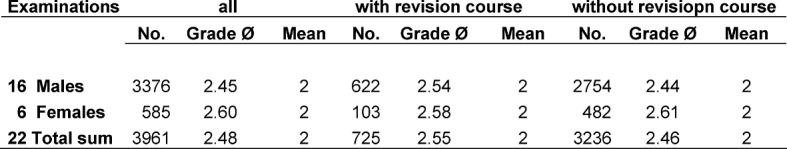
Arithmetic mean and median value of all examination results, from the experimental group with revision course and the comparison group without revision course, separated by the gender of the examiner.